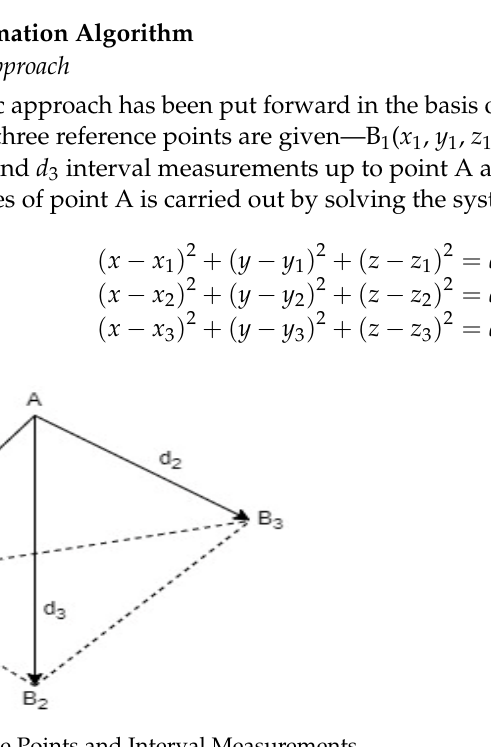
Figure 1. Reference Points and Interval Measurements.